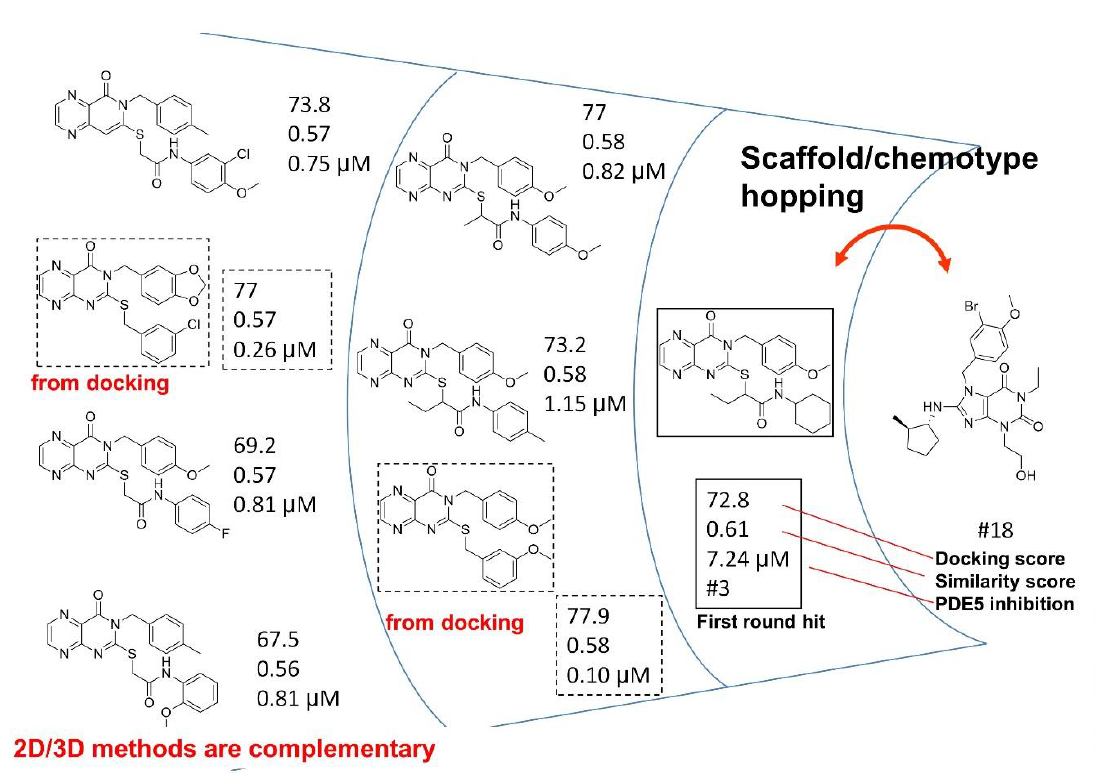
Figure 19. Structural evolution of PDE5 inhibitors coming from two rounds of similarity search.